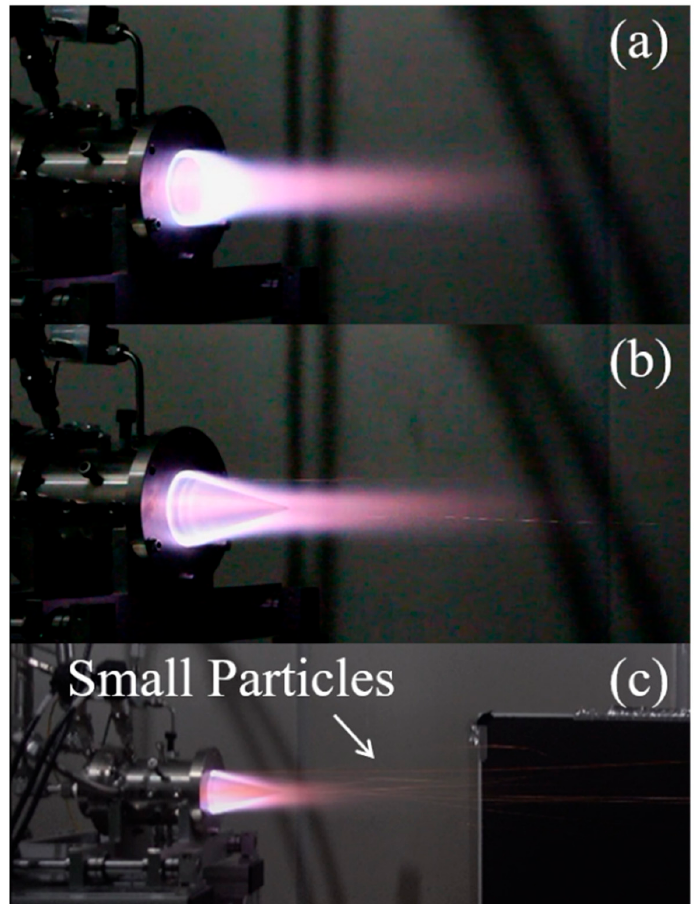
Figure 12. Pictures of RDE plume: ( a ) with bluff body at 𝑚(cid:4662) (cid:3047) = 152.6 g/s, 𝛷 = 0.45; ( b ) with conical center body at 𝑚(cid:4662) (cid:3047) = 163.0 g/s, 𝛷 = 0.47; ( c ) small particles owing to the ablation (3840 × 2160 resolution using Sony RX-100M5 camera).